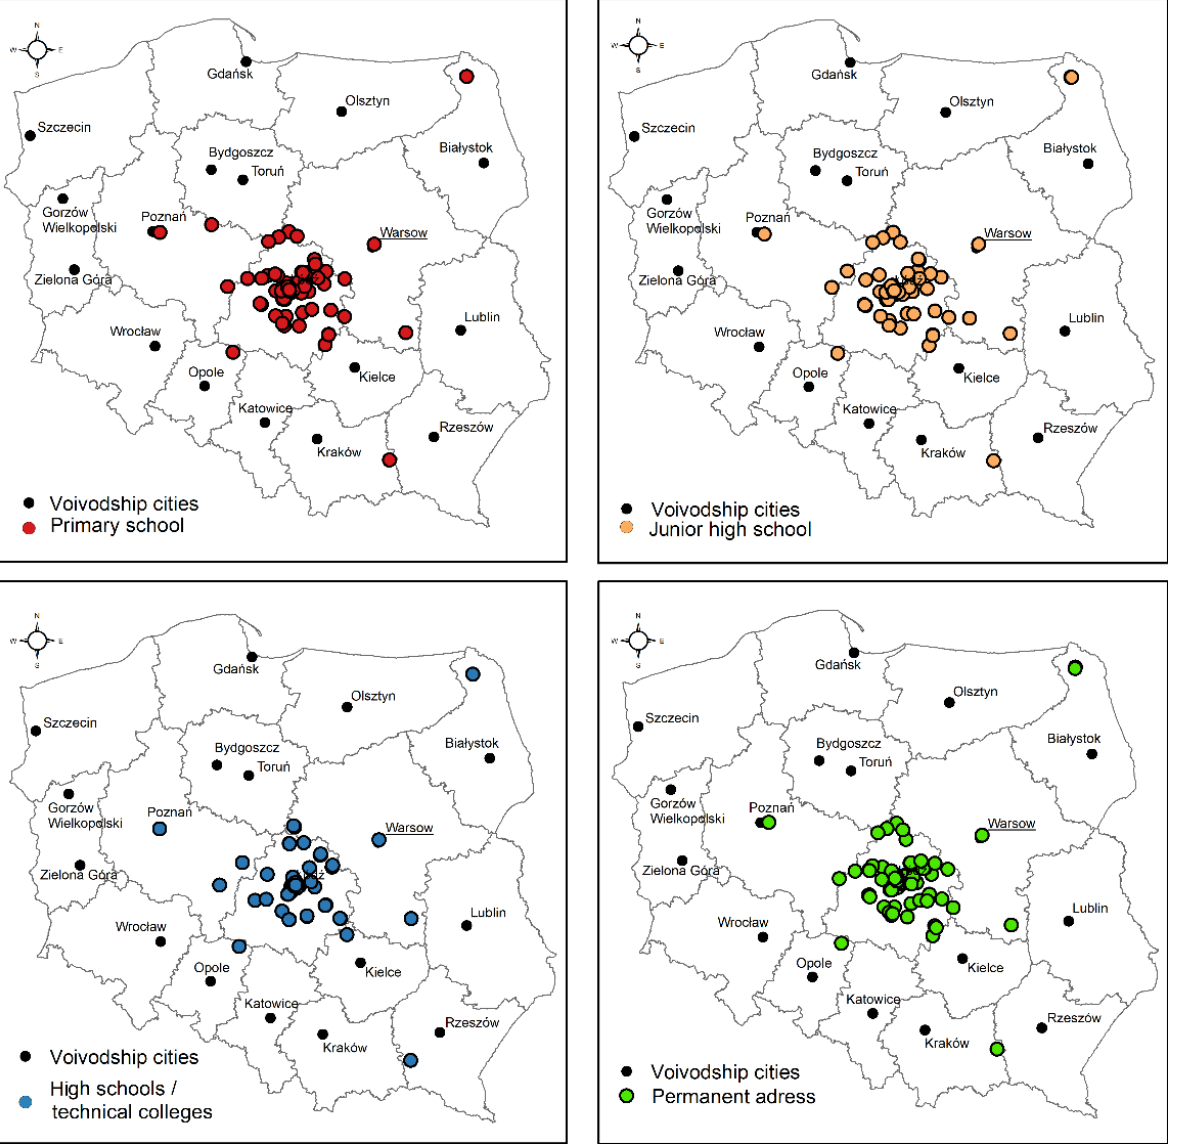
Figure 6. The locations of the schools completed by the studied students and their current permanent residence (excluding the student educated in Greece).